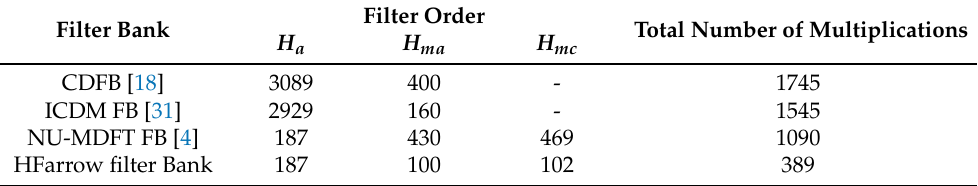
Table 7. Comparison of different multiplication complexities for non-uniform filter